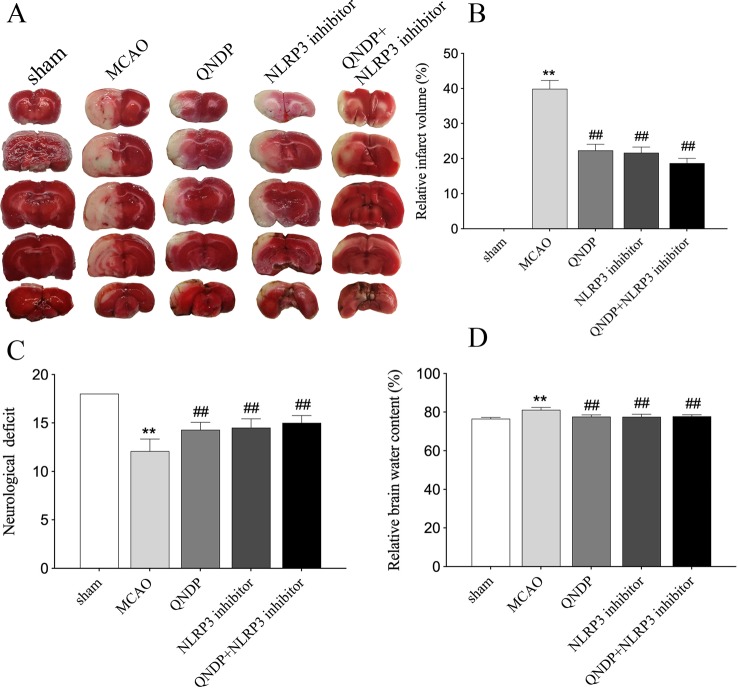
QNDP is neuroprotective in MCAO rats. (A) Images of cerebral infarction (white, infarct tissue; red, non-infarct tissue) were TTC-stained brain sections. (B) The infarct volume was quantified with Image J analysis and expressed as a percentage of the damaged ipsilateral hemisphere. (C) Neurological deficit by Garcia JH scores. (D) Brain water content. Data are presented as means ± SEM, n = 8 per group, **p < 0.01 compared with the sham group, ##
p < 0.01 compared with the MCAO group.